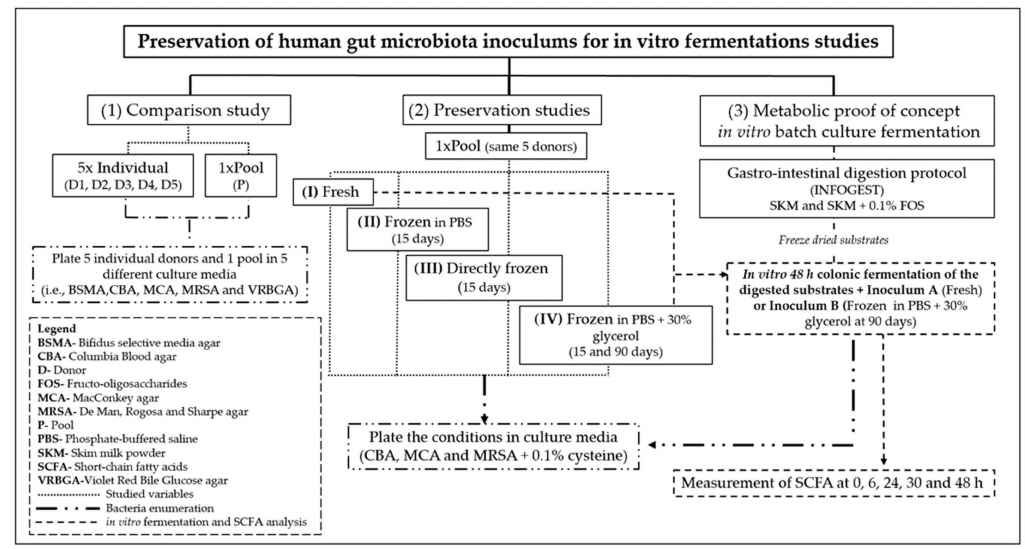
Figure 1. Schematic model of the methodology applied in this study. Table 1. Volunteer Detailed Information (1), Composition of Individual Inoculums (2), and Pooled Inoculum (P-Fresh) (3). Donors Information